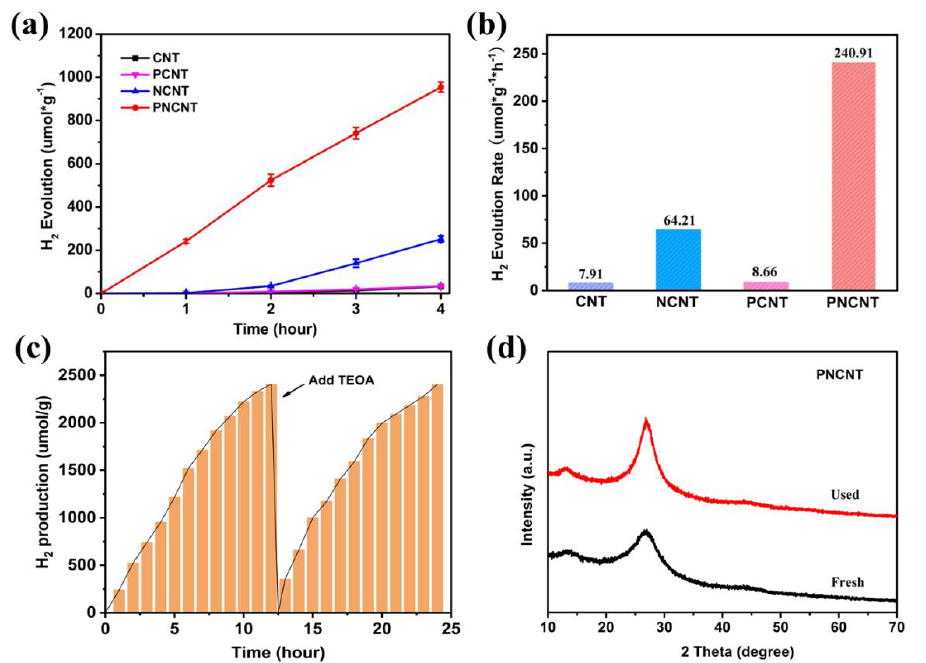
Figure 6. Time courses of photocatalytic H 2 evolution ( a ) and H 2 evolution rate ( b ) of CNT, NCNT, PCNT, PNCNT samples under visible light; photocatalytic H 2 evolution stability test of PNCNT ( c ), the XRD pattern of fresh and used PNCNT after photocatalytic H 2 evolution stability tests ( d ).